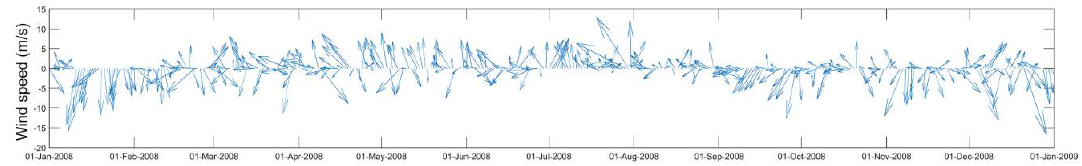
Figure 10. Time series of wind vectors of year 2008, with north wind pointing to the top, length of each arrow refers to the wind speed.